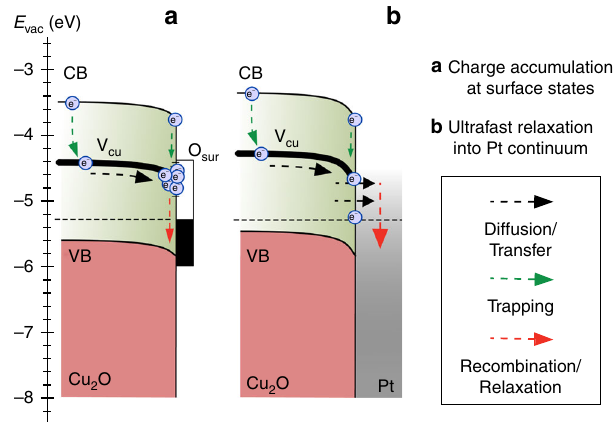
Fig. 4 Energy-band diagram. Band bending and carrier dynamics at the surface of the reconstructed ( a ) and Pt-deposited Cu 2 O (100) single crystals ( b ). The energy-band positions and band bending were measured by steady-state 2PPE and XPS measurements referenced to the vacuum level. In a , charge transfer and accumulation occur at defect states (V Cu ) located within the bandgap. In contrast, in b , deposition of a Pt adlayer leads to ultrafast charge extraction and relaxation into the Pt continuum